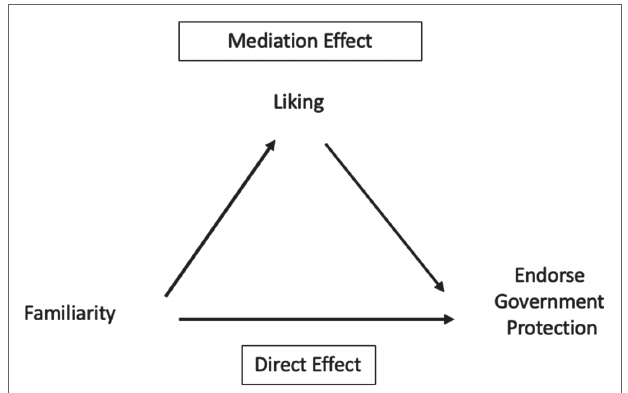
FIGURE 4 | Model. The total effect of familiarity on the extent to which people endorse government protection is decomposed into two causal pathways. The top pathway reflects a mechanism through which the effect of the extent to which people are familiar with the threatened animal is mediated by how much they like the animal. The bottom direct pathway between familiarity and endorsement represents alternative mechanisms not intervened by how much they like the